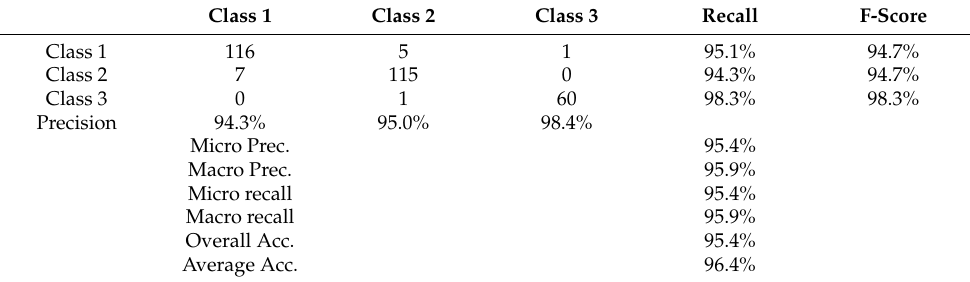
Table 2. The classification by GoogleNet with 21 epoch.